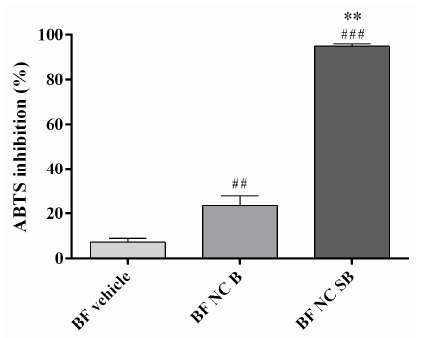
Figure 4. Percentage of ABTS radical inhibition by films. Each column represents the mean ± SD. (**) p < 0.01 significant differences between bilayer film containing nanocapsules with (BF NC SB) or without (BF NC B) silibinin, (##) p < 0.01 and (###) p < 0.001 significant differences between BF NC SB or BF NC B and BF vehicle (One-way ANOVA followed by the Tukey’s test).